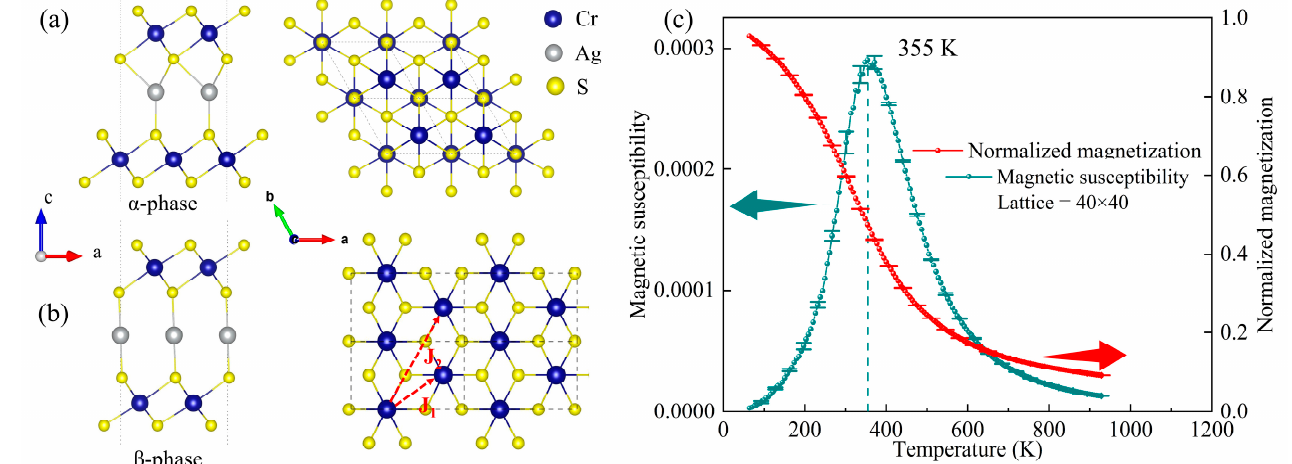
Figure 2. ( a , b ) The top and side views of the AgCr 2 S 4 asymmetric α phase (P3m1) and the centro- symmetric β phase (C2/m), respectively. The nearest neighbor interaction J 1 and the next-nearest neighbor interaction J 2 are denoted by the red dotted arrows in the right panel of ( b ). ( c ) The MC simulated magnetic susceptibility and normalized magnetization as a function of temperature for the AgCr 2 S 4 monolayer.